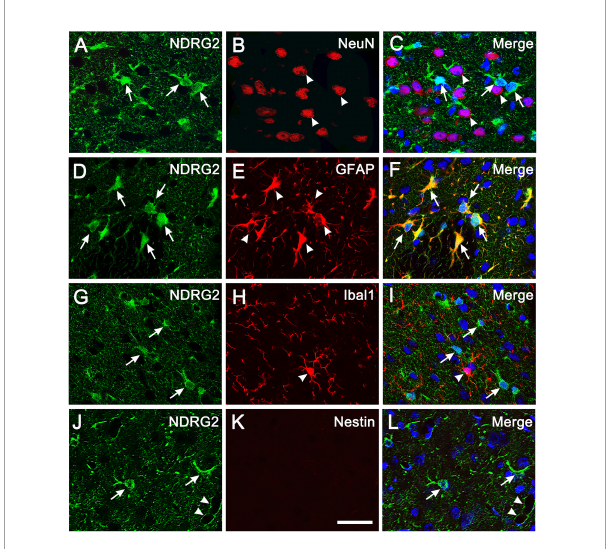
FIGURE1 NDRG2 is exclusively expressed in astrocytes in rat cortical parenchyma. Immunostaining for NDRG2 (green) and cellular markers (red) including NeuN, GFAP, Iba1, and Nestin, was performed on normal cortical sections in rats. (A–I) NDRG2 was exclusively co-labeled with GFAP (D–F) but not with NeuN (A–C) , or IbaI (G–I) . (J–L) Nestin was not expressed in normal cortical parenchyma (K) . Cell nuclei were counterstained with Hoechst33342 (blue). Arrows show representative NDRG2-positive cells and arrowheads show representative NeuN-, GFAP- and Iba1-positive cells. Arrowheads in panel (L) show the immunoreactivity of NDRG2 surrounding blood vessels. Scale bar in panel (K) : 30 µ m.